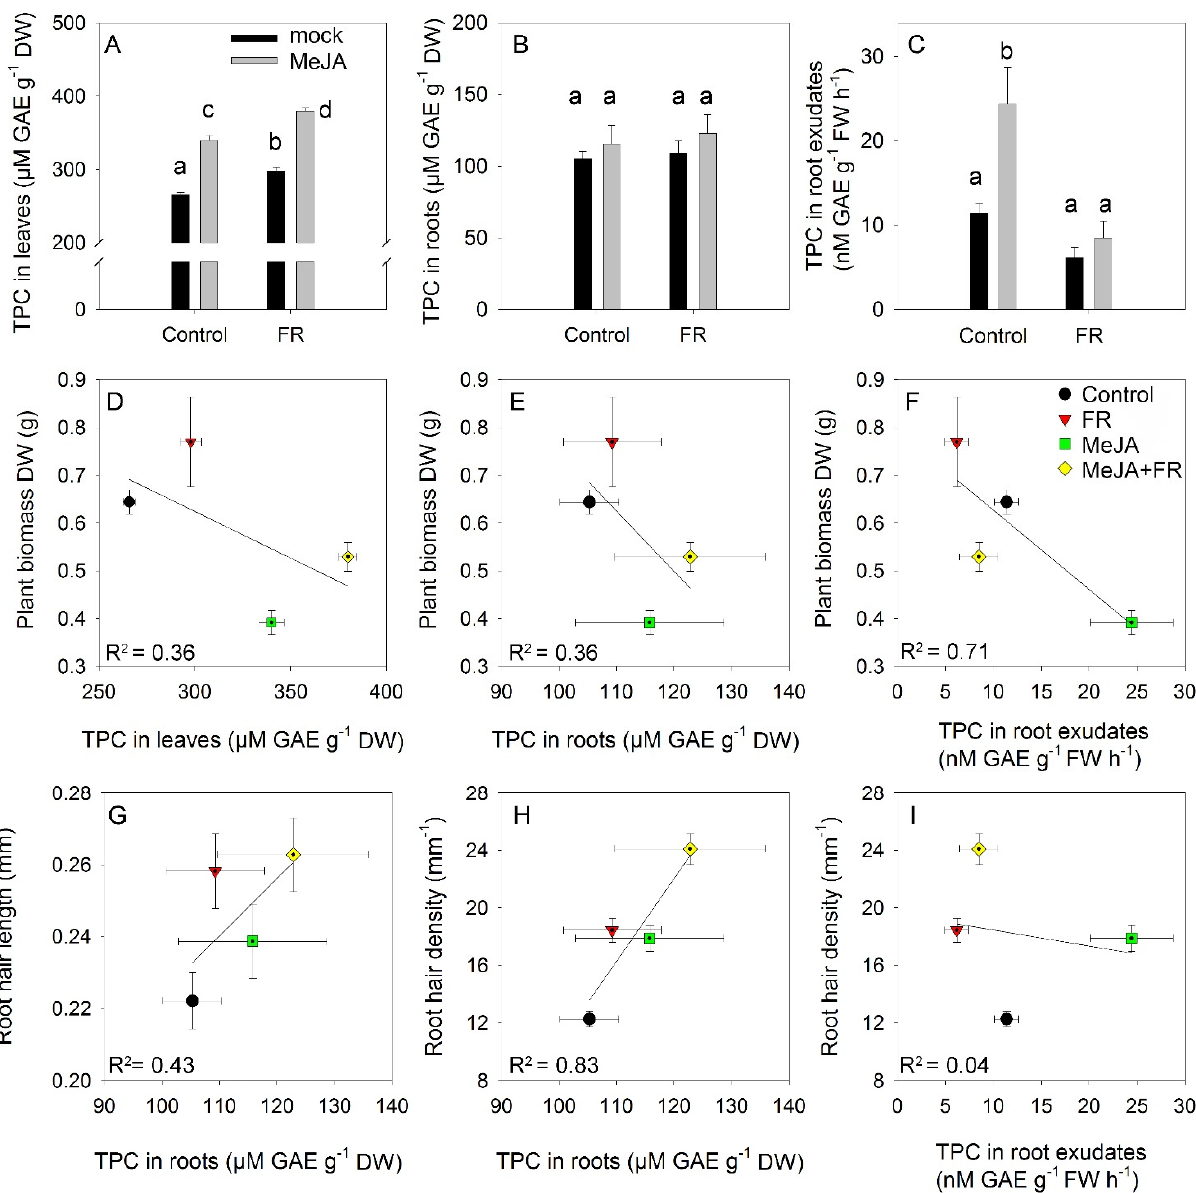
Figure 6. The effect of far-red light and methyl jasmonate (MeJA) application on total phenolic compounds (TPC) in leaves ( A ), roots ( B ), and root exudates ( C ) of Hypericum perforatum ( n = 6). Differences between means with different letters are statistically significant. Relationships between plant biomass and TPC concentration in leaves ( D ), roots ( E ), and root exudates ( F ). Relationships between root hair length and TPC in roots ( G ). Relationships between root hair density and TPC in roots ( H ) and TPC in root exudates ( I ).